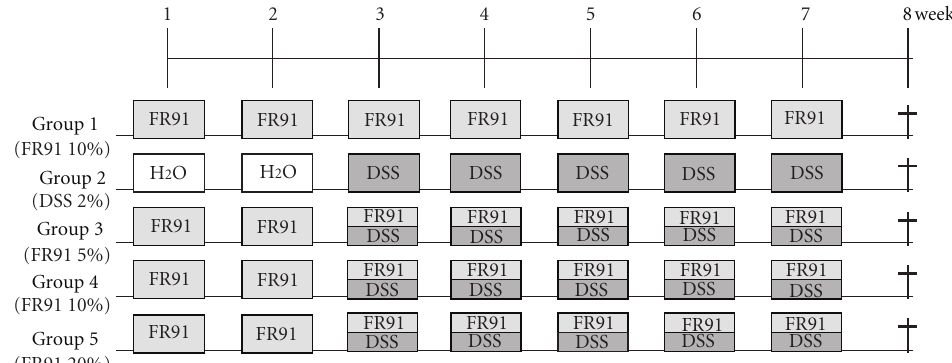
Figure 1: Experimental protocol for DSS-induced colitis/colon cancer in mice and the administration of FR91 at di ff erent concentrations.